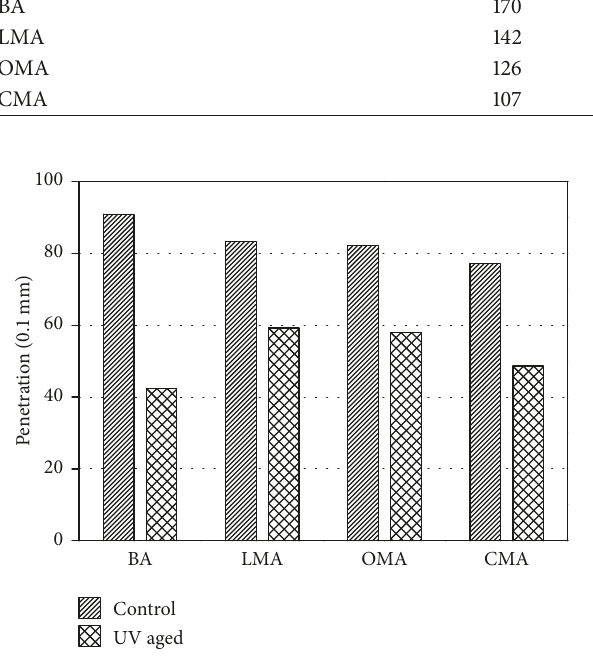
Figure 7: Penetration of UV aged and unaged asphalt.